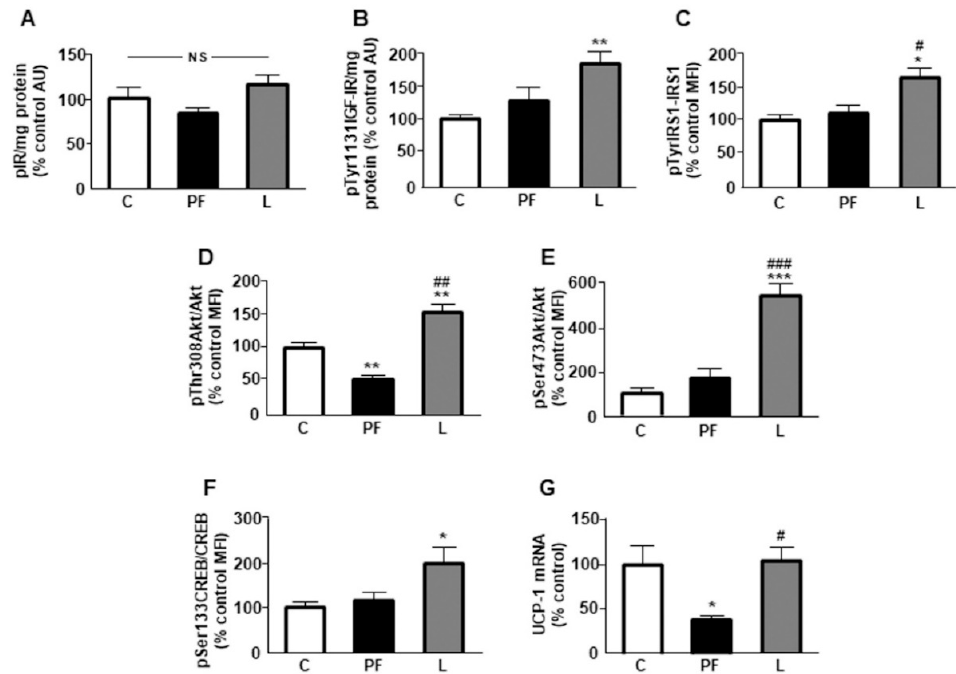
Figure 2. Effects of central leptin infusion on intracellular signaling in brown adipose tissue (BAT). Relative protein levels of ( A ) phosphorylated (p) insulin receptor (pIR), ( B ) insulin-like growth factor-I receptor (IGF-IR) phosphorylated at Tyr1131 (pTyr1131IGF-IR), ( C ) insulin receptor substrate 1 (IRS1) phosphorylated at Tyr residues, ( D ) Akt phosphorylated at Thr308 (pThr308Akt), ( E ) Akt phosphorylated at Ser473 (pSer473Akt), ( F ) cAMP response element binding protein (CREB) phos- phorylated at Ser133 (pSer133CREB) and ( G ) relative uncoupling protein (UCP)-1 mRNA content in the interscapular BAT of control rats (C), pair-fed rats (PF) and rats receiving a chronic icv leptin infusion (L). Data are presented as means ± SEM. N = 5. AU, absorbance units, MFI, median fluores- cent intensity; NS, non-significant. * p < 0.05, ** p < 0.01 *** p < 0.001 vs. C; # p < 0.05, ## p < 0.01, ### p < 0.001 vs. PF.